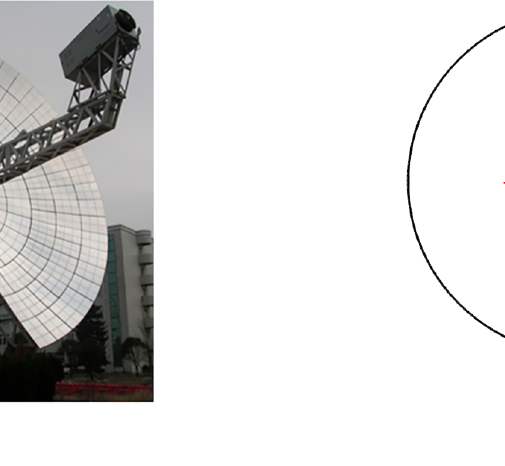
Figure 1. The 38 kW solar dish Stirling thermal power (SDSP) generation system developed by the authors [7]. ( a ) The physical diagram of the SDC system. ( b ) The geometric parameters of the concentrator [9].